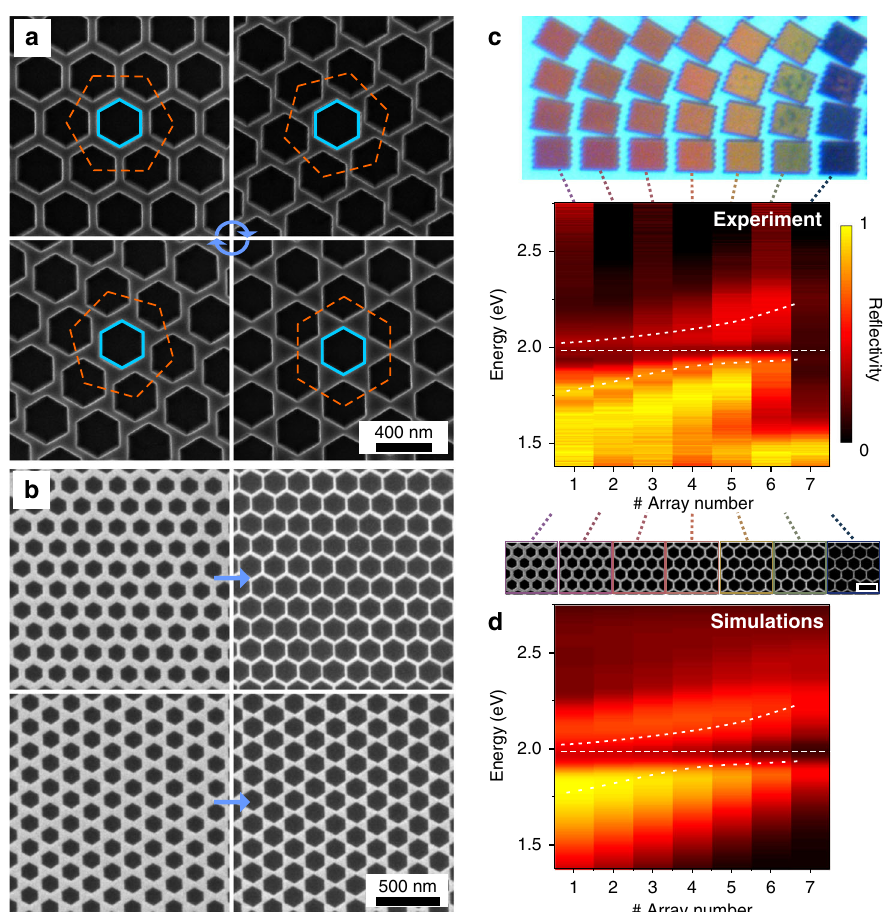
Fig. 3 A variety of etched hexagonal hole arrays and their optical properties. a SEM images of hexagonal hole arrays with various rotational angles (15° step) with respect to the orientation of individual hexagonal holes in a WS 2 fl ake. The orange-dashed and blue hexagons identify the orientations of hexagonal lattice arrays and individual hexagonal holes, respectively. b SEM images of honeycomb and bow-tie hexagonal hole arrays with fi xed lattice periodicity but different hole sizes (bigger holes are shown to the right). c True-color optical microscope image and re fl ectivity spectra of hexagonal arrays with various hole sizes and lattice orientations in ~70nm thick WS 2 . The bottom row of the optical image consists of honeycomb arrays with variable hole sizes ranging from 240 to 300nm (left to right) and a fi xed lattice pitch of 400 nm, and their SEM images are shown, respectively. The scale bar is 500 nm. c Experimental and d simulated re fl ectivity spectra. Dashed lines are guides for an eye, indicating the A-exciton energy and the avoided